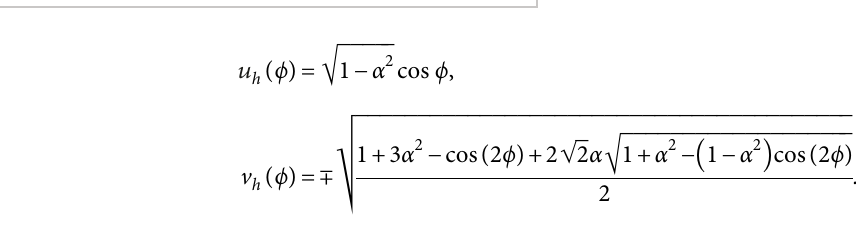
Figure 9: Diagrams for the unperturbed system (15) when α � 0 . 5 and ω unperturbed system.